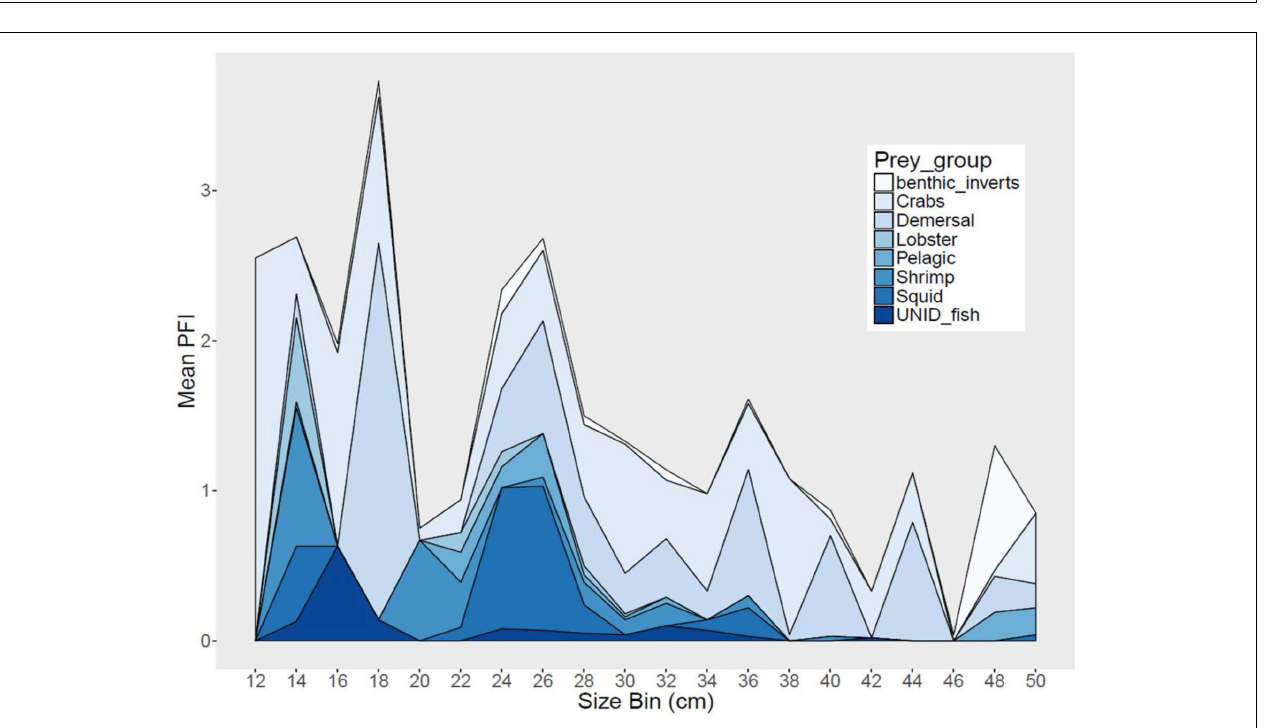
FIGURE 4 | Stacked area graph of mean partial fullness index (Mean PFI) by 2 cm size bins for black sea bass from all regions combined.